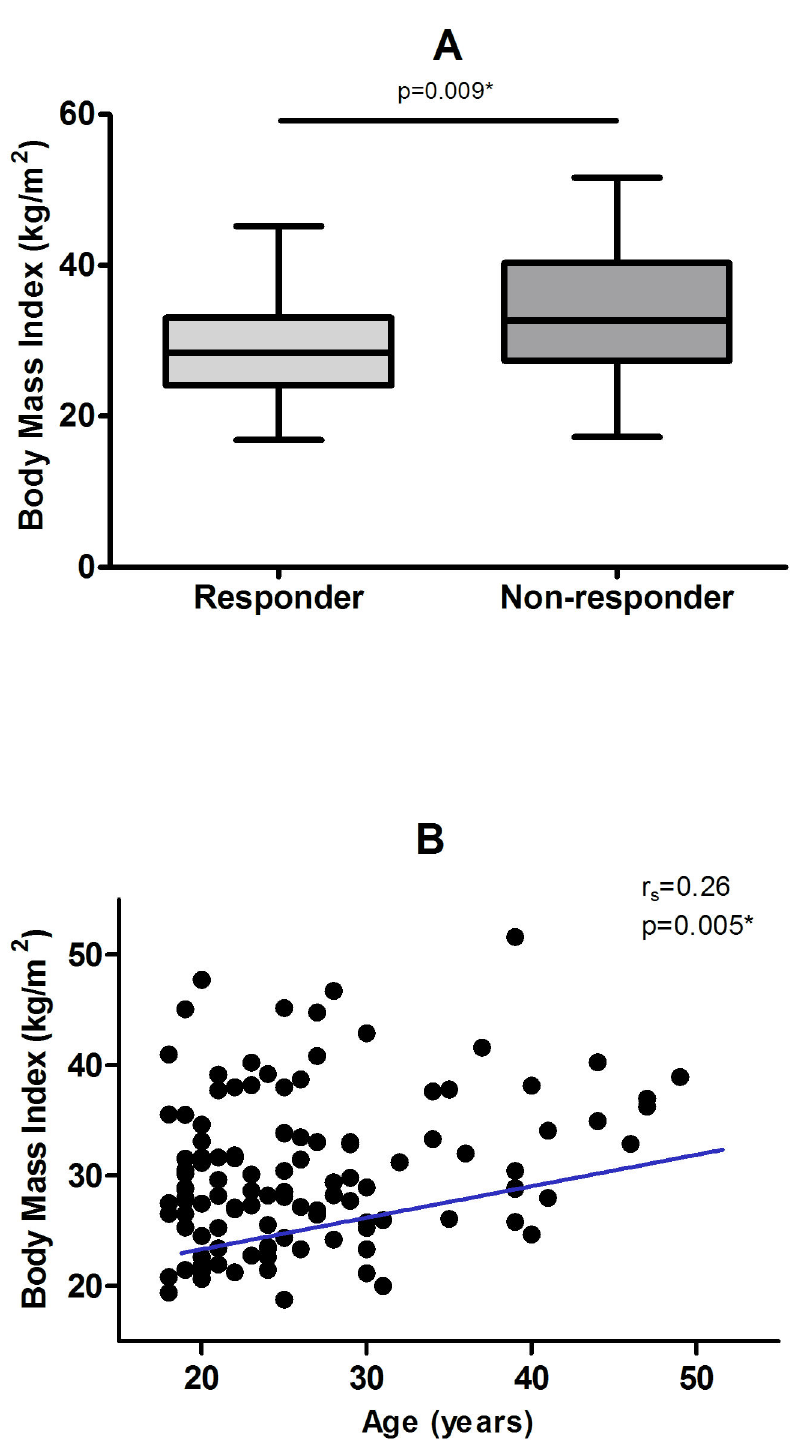
Figure 1. Associations of body mass index (BMI). (A) Box-and-whisker plot showing the relative distribution of BMI by vaccine response group (median, Interquartile range, minimum and maximum shown) (B) Spearman’s correlation of age at first vaccination and BMI.